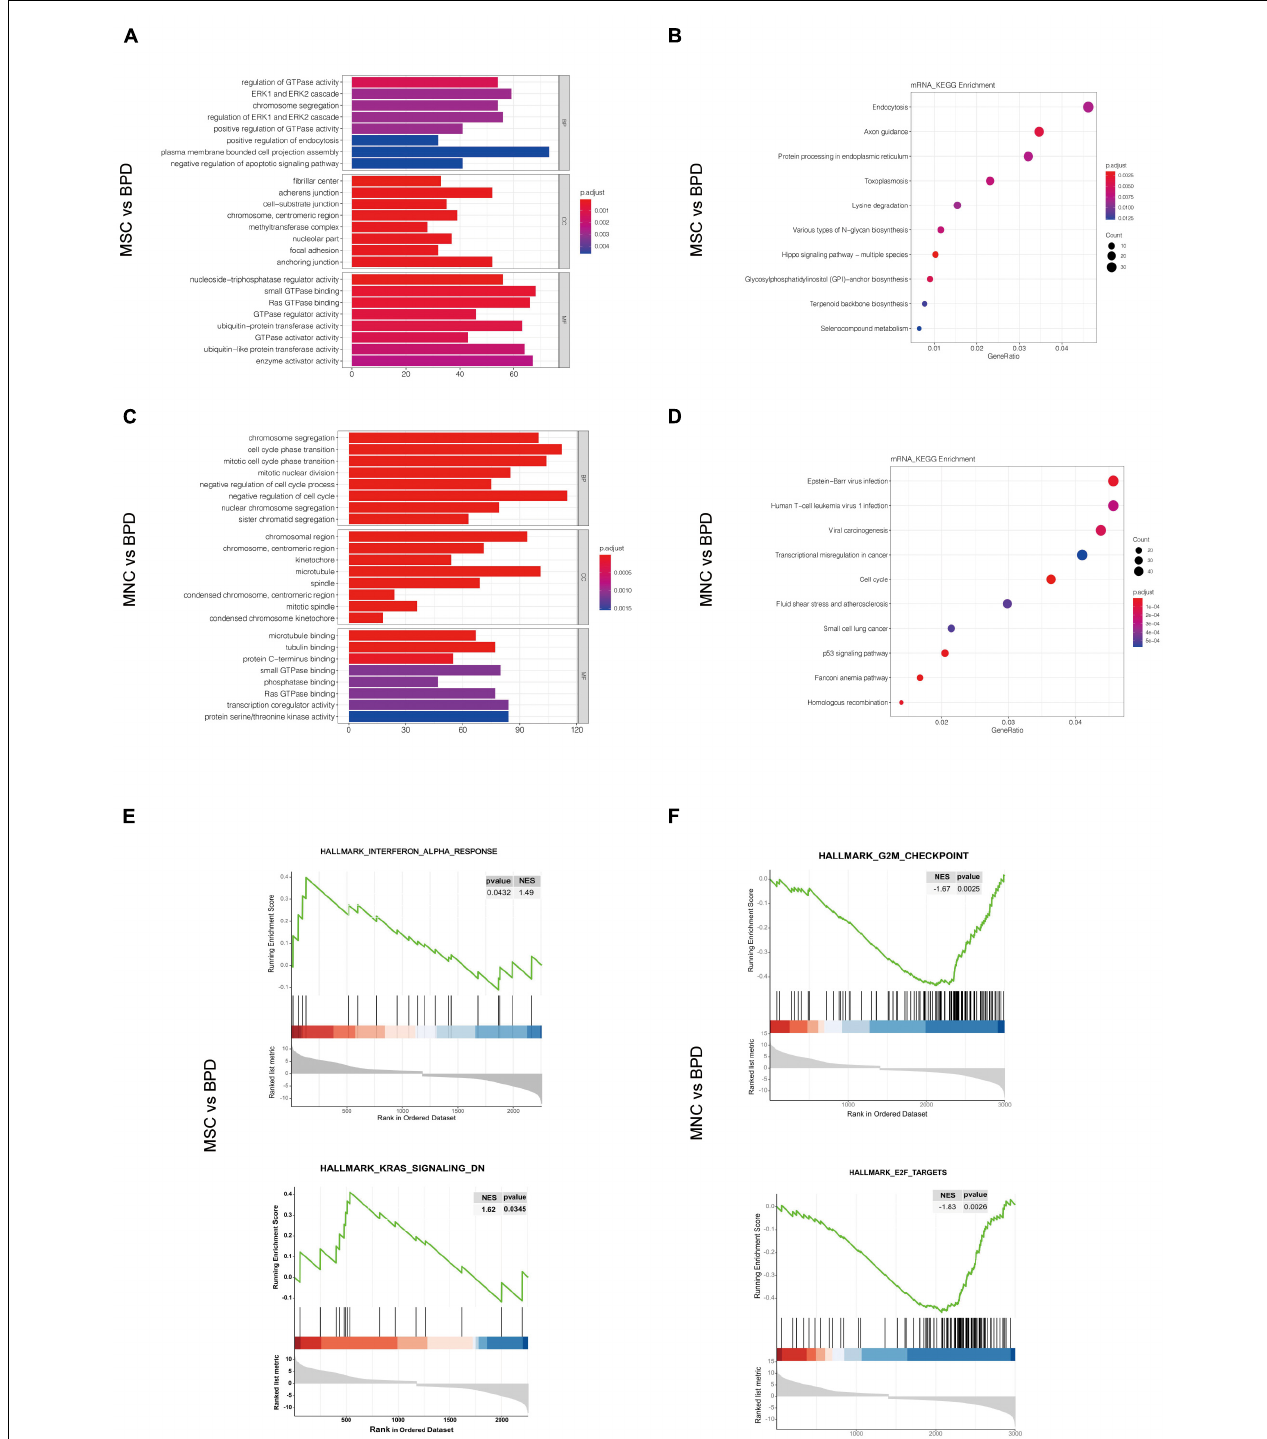
FIGURE 8 | Pathway analysis for the differentially expressed mRNAs (DEmRNAs). (A,B) Gene Ontology (GO) analysis of the significantly differently expressed mRNAs in umbilical cord-derived mesenchymal stem cell (UC-MSC)-infused (A) and cord blood-derived mononuclear cell (CB-MNC)-infused bronchopulmonary dysplasia (BPD) mice (B) relative to BPD mice. (C,D) Kyoto Encyclopedia of Genes and Genomes (KEGG) analysis significantly differently expressed mRNAs in UC-MSC-infused (C) and CB-MNC-infused BPD mice (D) . (E,F) Enrichment plots of gene expression signatures for topmost signaling hallmarks by gene set enrichment analysis (GSEA) of DEmRNAs in UC-MSC-infused group and CB-MNC-infused group.